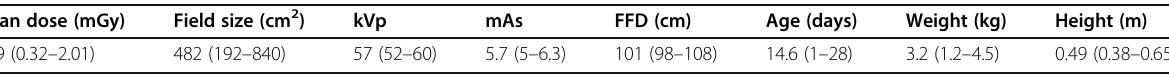
Table 6 Mean parameters and ranges for the AP chest X-ray Mean dose (mGy)